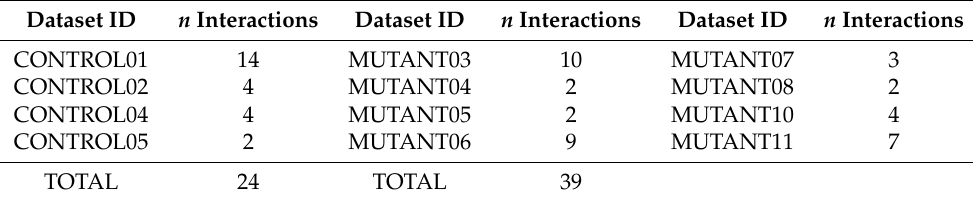
Table 1. Number of suitable interactions per dataset Each dataset corresponded to one Drosophila embryo. Initially, five control and 11 mutant datasets were analysed. Of these, one control (04) and three mutant datasets (01, 02, 09) did not provide any suitable interactions, mainly due to clumps that were formed by more than two cells. The different number of interactions per dataset should be noticed, which was due to the variability of the cell interactions.